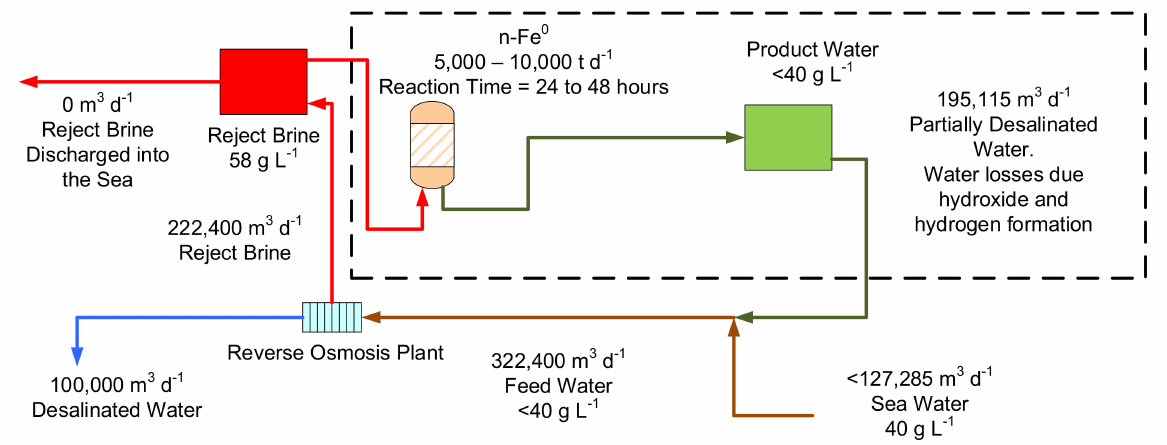
Figure 19. Conceptual design for a zero-waste discharge conventional desalination plant based on 2016 technology, where the n-Fe 0 was not reusable. n-Fe 0 requirements are reduced, if the n-Fe 0 can be reused over a prolonged period. n-Fe 0 reaction profile as shown in Figure 14, requiring a